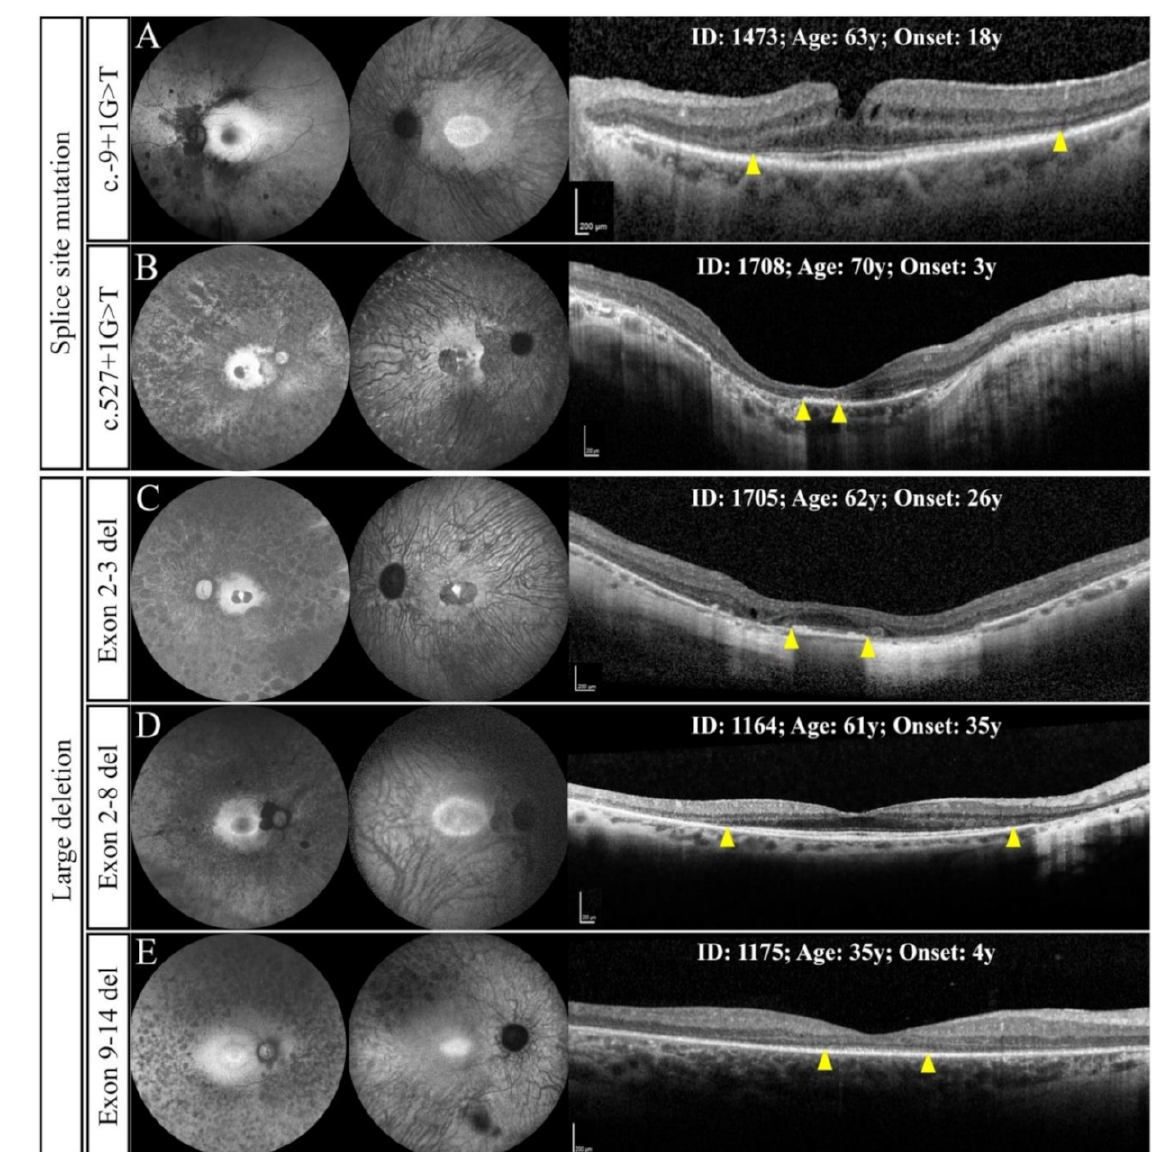
Figure 4. Ultra widefield autofluorescence (UWF AF) and spectral-domain optical coherence tomography findings in patients with splice site mutations ( A , B ) and large deletions ( C – E ). Whilst patient 1473 revealed a large hyperautofluorescent ring (HAR) and wide ellipsoid zone (EZ) span ( A ), patient 1708 showed extensive loss of normal autofluorescence and barely detectable EZ ( B ). Similarly, patients with large deletions revealed wide variation, including no HAR and small EZ ( C ) at age 62 years, large HAR and EZ at age 61 years ( D ) and small HAR and EZ at age 35 years ( E ). Yellow arrowheads show nasal and temporal EZ